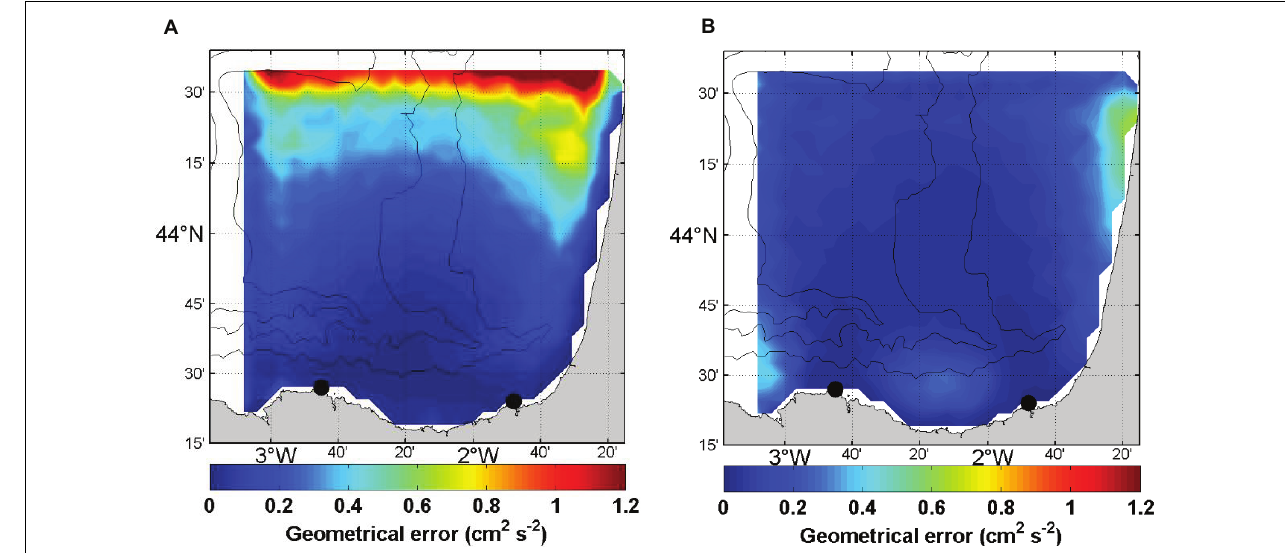
FIGURE 6 | Geometrical error (cm 2 s − 2 ) of the zonal (A) and meridional (B) components of the HF radar currents from the OMA data and 2009–2017 period. The black points indicate the location of the HF radar antennas.